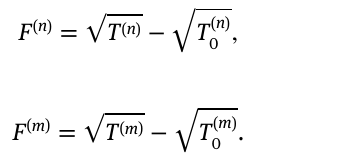
(Figure1(b)),andtheheatwilldiffuseoncethemicrosphere moves away from the original position, thus, the back- ground temperature would also increase